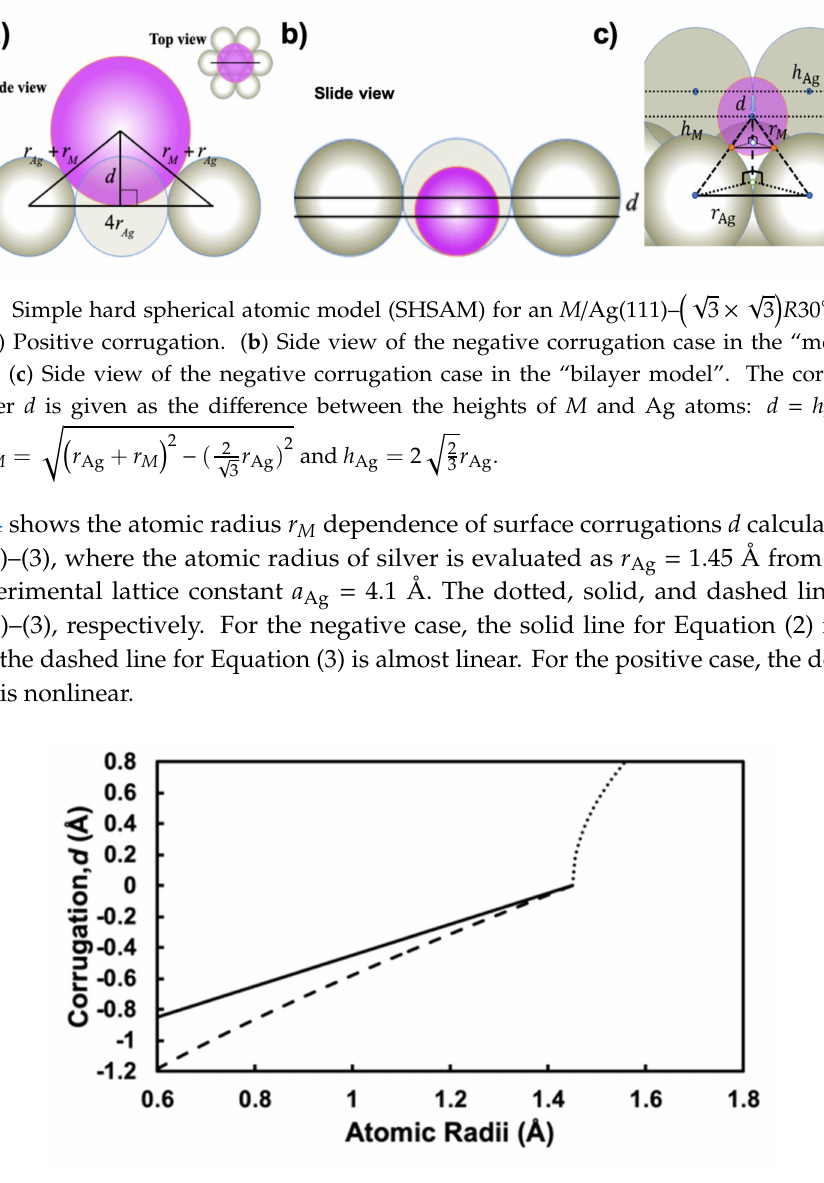
Figure 4. Corrugation parameter d calculated with Equations (1)–(3) in the main text, where r Ag = 1.45 Å. The dotted line shows positive corrugation given by Equation (1). The solid line and dashed line show negative corrugation given by Equations (2) and (3) with “monolayer model” and “bilayer model”,